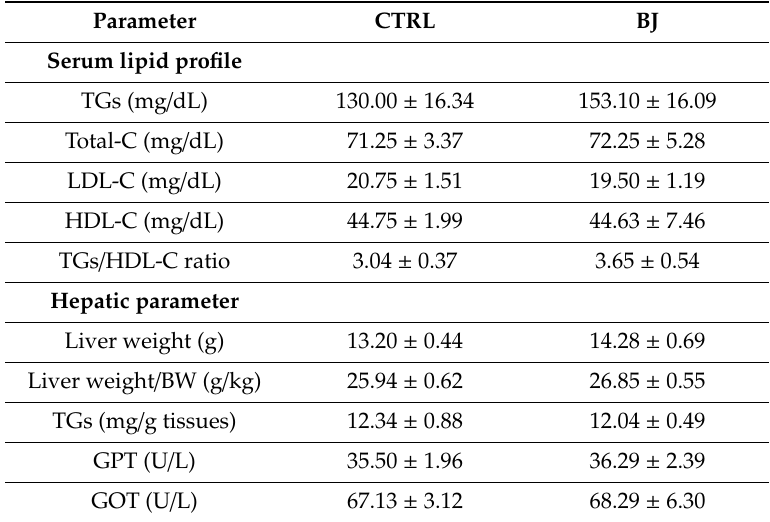
Table 4. Serum lipid profile and hepatic parameters.